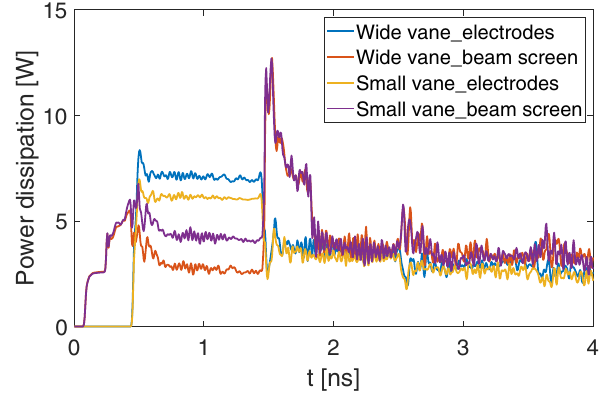
FIG. 8. Dependence of the longitudinal effective impedance on the rms bunch length.